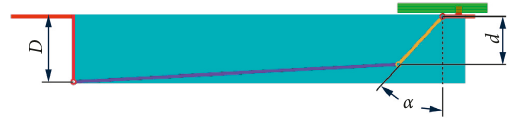
Figure 5: Spectrum of K 29.